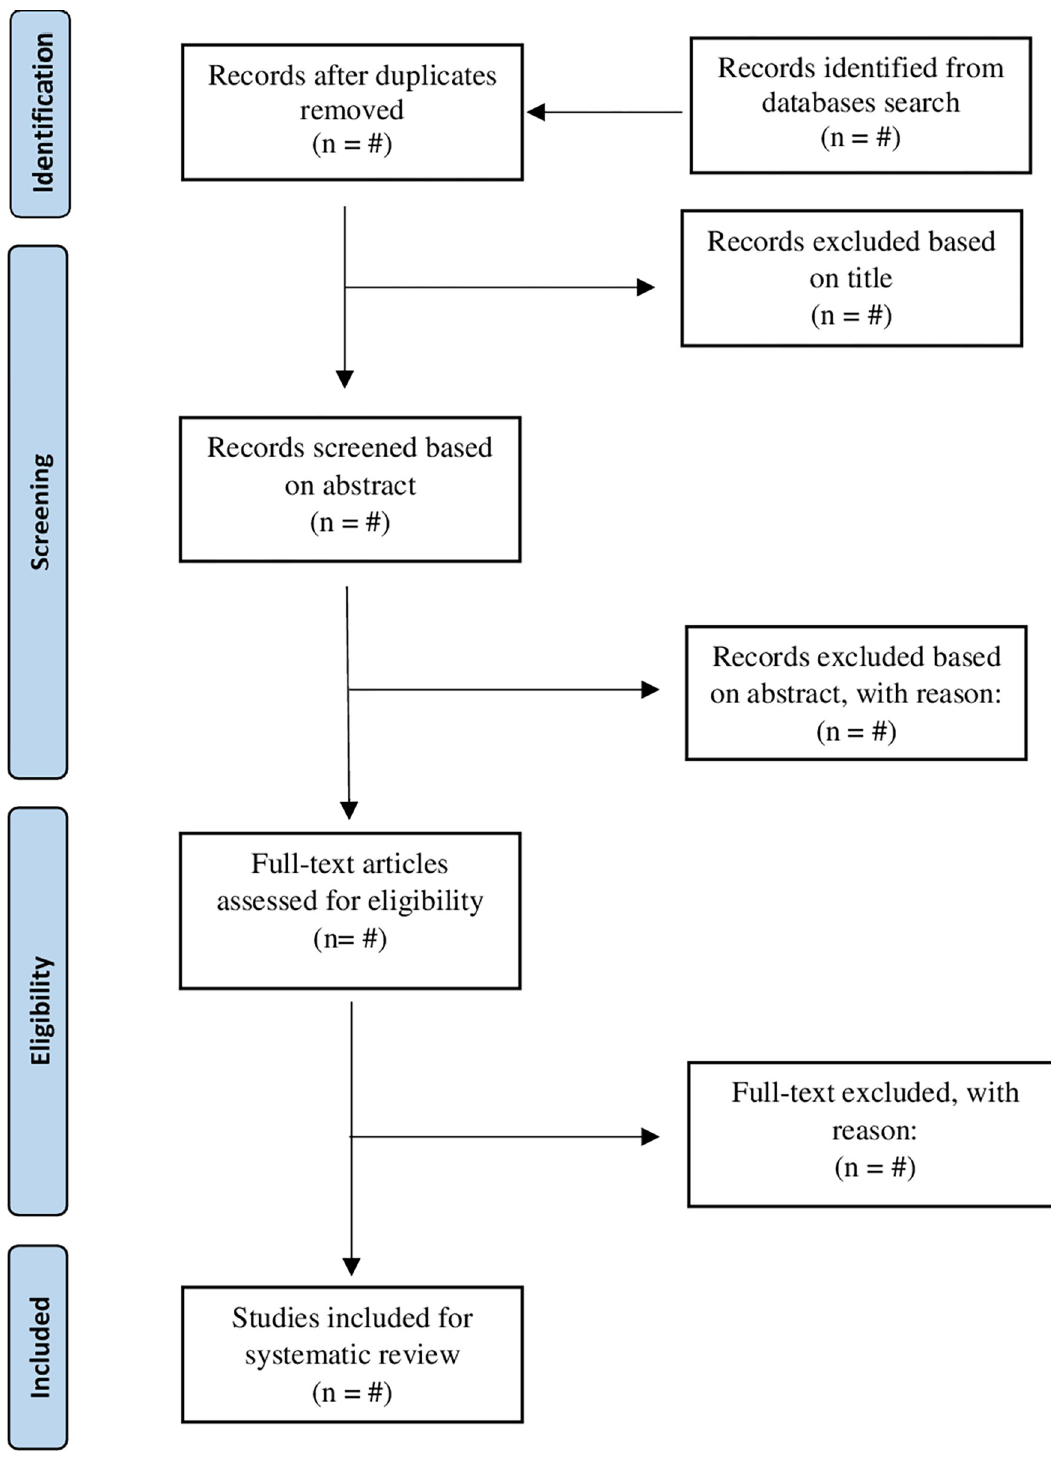
Fig 1. PRISMA flow